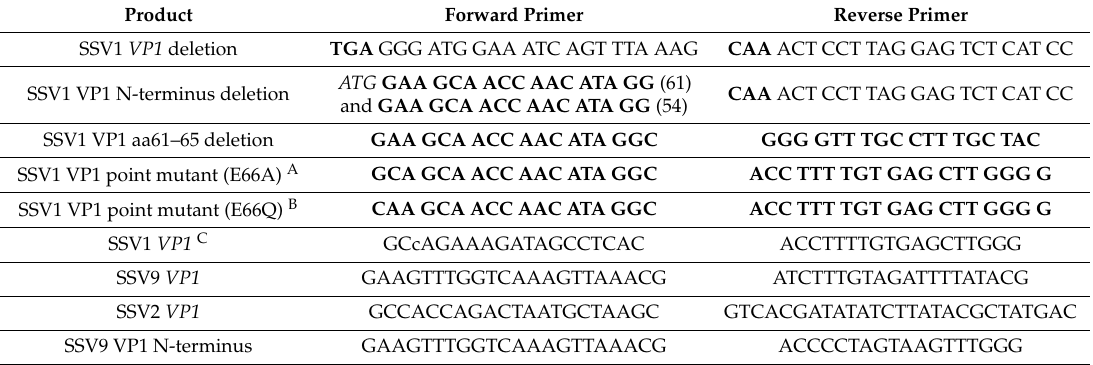
Table 2. Primers used in this